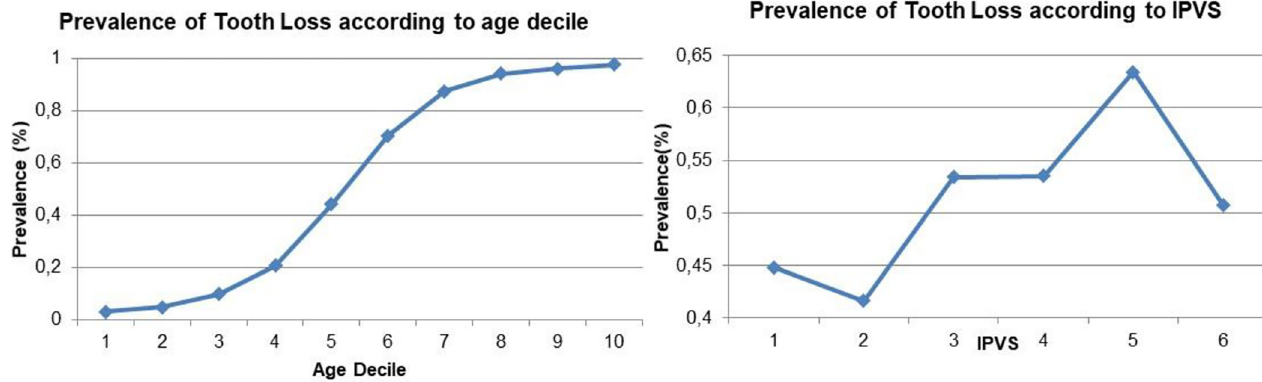
Fig 2. Prevalence of tooth loss by age decile and by IPVS category.